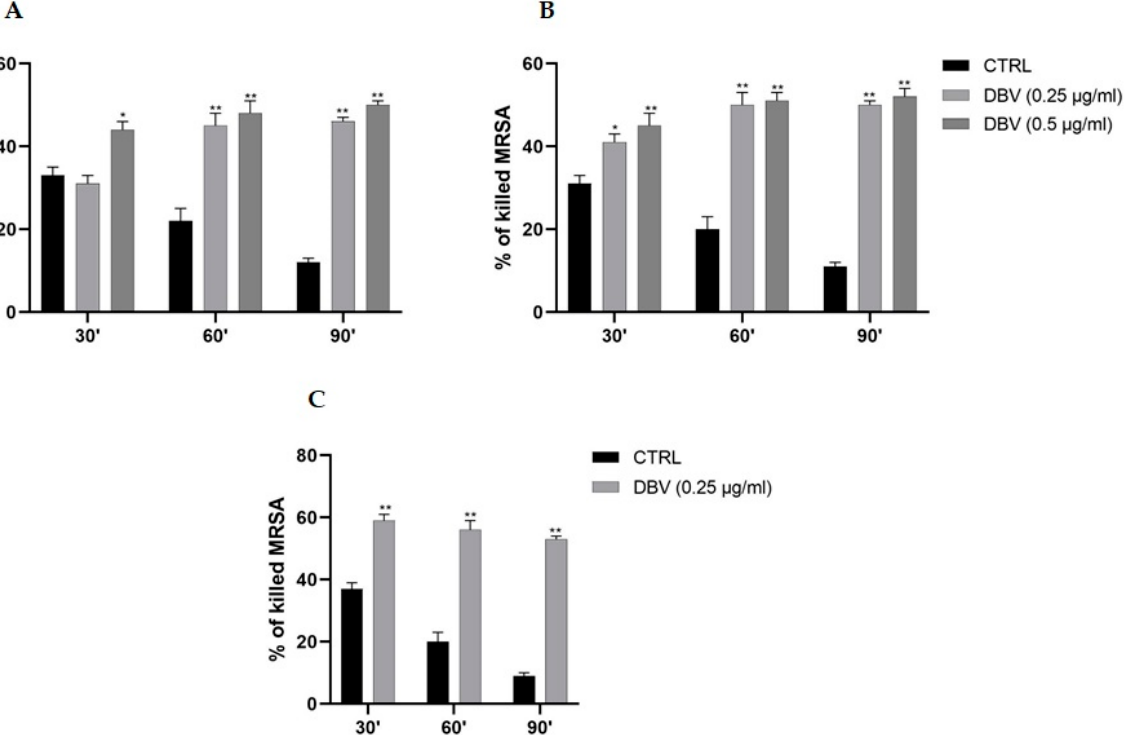
Figure 1. DBV enhances intracellular MRSA killing activity of human PMNs. PMNs (10 6 cells/mL) and MRSA (10 7 CFU/mL) were incubated with DBV (at MIC or 2xMIC) and their killing activity was evaluated at 30 ′ , 60 ′ and 90 ′ ( A ). In pre-treated experiments, MRSA ( B ) or PMNs ( C ) were pre-treated for 60 ′ with DBV, then they were put together and the PMNs killing activity towards MRSA was evaluated. Data are shown as killing percentages from at least three independent experiments. * p < 0.05 ** p < 0.001 CTRL vs. DBV.